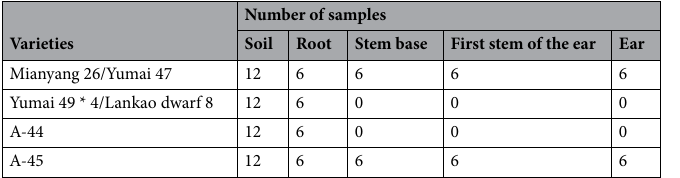
Table 1. Sample collection information. The samples for each variety of wheat were collected from both inoculated and uninoculated